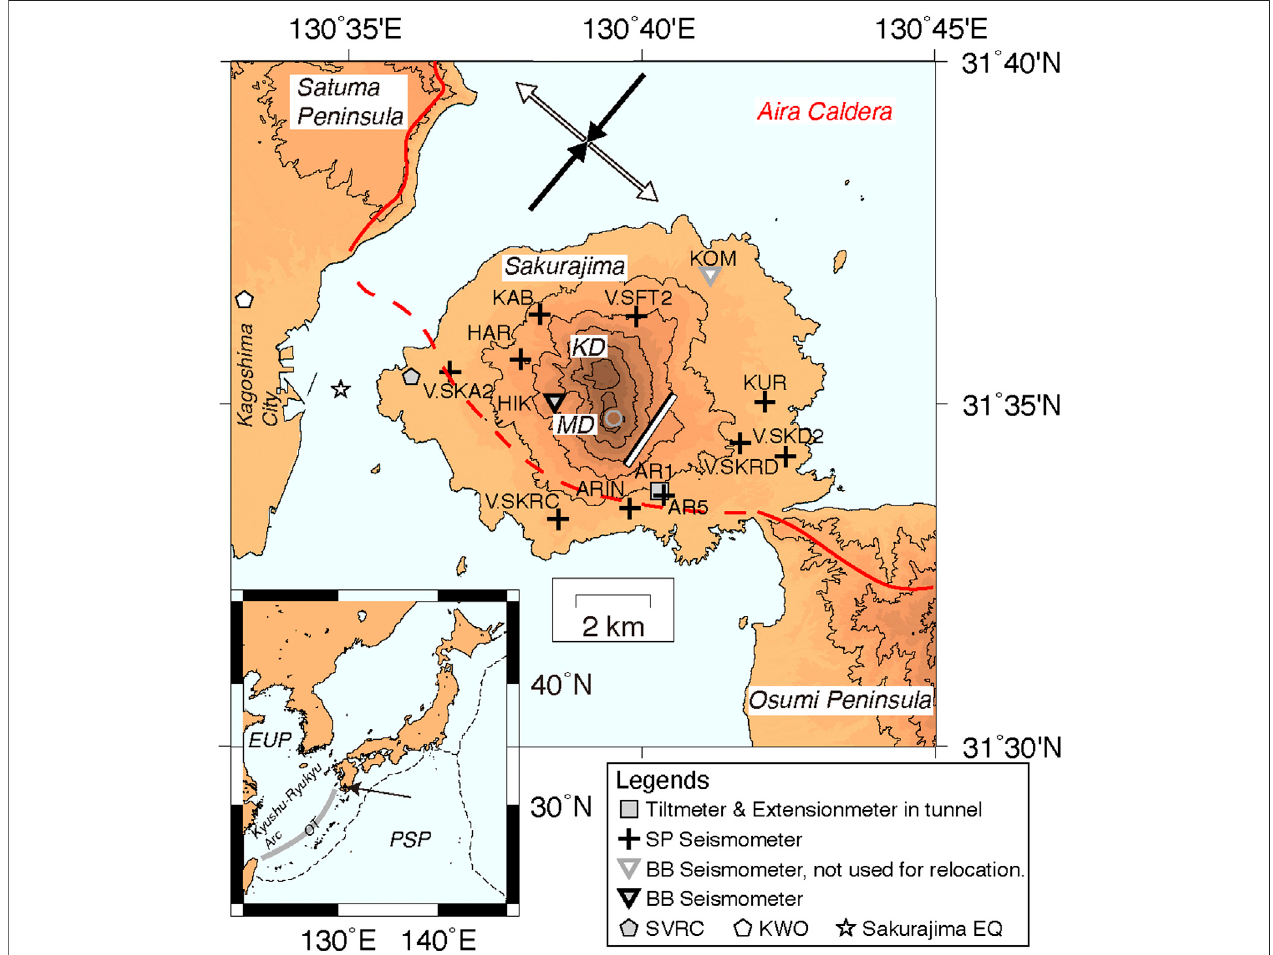
FIGURE 1 | Map showing the locations of Sakurajima volcano and seismic stations. Inset shows the location of Sakurajima relative to Japan. The abbreviation KD and MD indicate theKita-dake (old clatter) and Minami-dake (currently the most active crater). Contours are provided every 200 m. The plus signs and inverted triangles show the locations ofthe short-period and broadband seismic stations, respectively,used for theanalysesofthe hypocenters and focal mechanisms,except for station KOM, which was used only for short-term-/long-term-average seismic detection. The gray square indicates the station AR1, which has short-period seismometer and tiltmeter and extension meters in an underground tunnel, and it was also used for the analyses. Open and solid black arrows indicate the directions of the regional maximumextensionandcompression,respectively,ofthestress fi eldatadepthof10 km(TerakawaandMatsu ’ ura,2010).Therectangleshowsthelocationofthedike source obtained from the ground deformation on August 15, 2015 (Hotta et al., 2016a).The thick black line of the rectangle represents the top of the dike. The gray and open pentagons show thelocations oftheSakurajima VolcanoResearchCenter(SVRC)and theKagoshimaWeather Observatory(KWO) atthetimeoftheTaisho1914 eruption. The open star shows the epicenter of the Sakurajima M (cid:1) 7 earthquake (Omori, 1920).